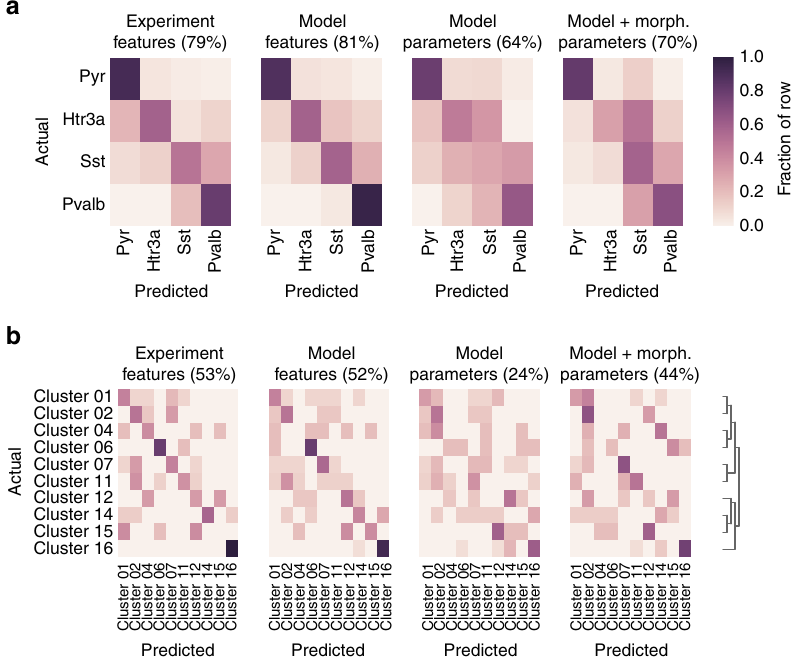
Fig. 7 Prediction of cell classes. a Prediction of transgenic line-de fi ned cell classes ( n = 146 cells). Note that all excitatory-dominant transgenic lines were combined into the “ Pyr ” category. b Prediction of cell classes generated by unsupervised clustering that used electrophysiological features from a broader set of cells based on the clustering from ref. 39 ; only clusters containing at least 5 cells from the set of models constructed here are shown ( n = 89 cells). Note that the referenced analysis identi fi ed 16 clusters; the cluster names shown here are consistent with that study, and clusters with too few cells in our study (i.e., clusters 3, 5, 8, 9, 10, and 13) are omitted. The tree at the far right shows the relative hierarchical relationships between the clusters. Predictions were made by a supervised classi fi er that used either the features of the experimental data that models were trained on (left), features of the optimized models (middle left), the parameters of the optimized models (middle right), or parameters of the optimized models as well as morphology-related values (right). Each entry within a heatmap shows the fraction of cells/models in a given row assigned to a particular